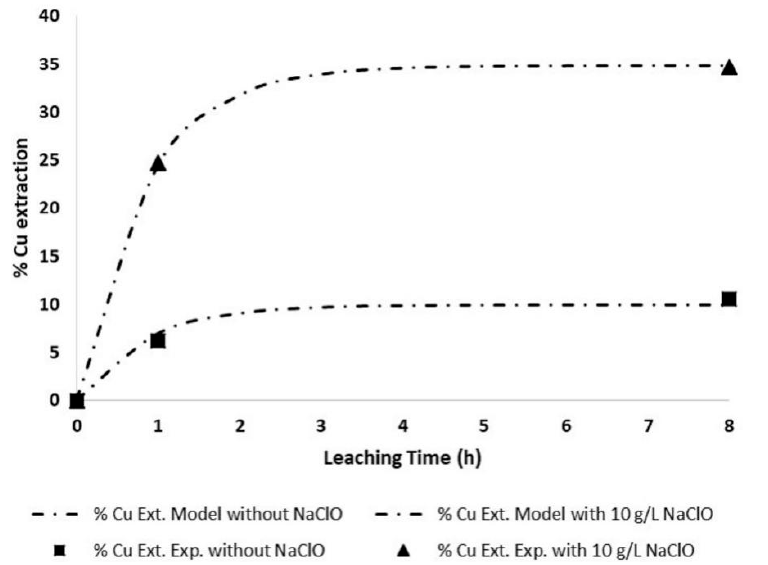
• ) copper dissolution v/s time. Experimental test without Figure 10. Experimental and modeled ( • Figure 10. Experimental and modeled (• ▬ •) copper dissolution v/s time. Experimental test with ‐ Figure 10. Experimental and modeled (• ▬ •) copper dissolution v/s time. Experimental test with- Figure 10. Experimental and modeled (• ▬ •) copper dissolution v/s time. Experimental test with- out NaClO and 1.5 M NH 4 Cl ( ■ ), and experimental test with 10 g/L NaClO and 1.5 M NH 4 Cl ( ▲ ). NaClO and 1.5 M NH 4 Cl ( (cid:4) ), and experimental test with 10 g/L NaClO and 1.5 M NH 4 Cl ( (cid:78) out NaClO and 1.5 M NH 4 Cl ( ■ ), and experimental test with 10 g/L NaClO and 1.5 M NH 4 Cl ( ▲ ). out NaClO and 1.5 M NH 4 Cl ( ■ ), and experimental test with 10 g/L NaClO and 1.5 M NH 4 Cl ( ▲ ).